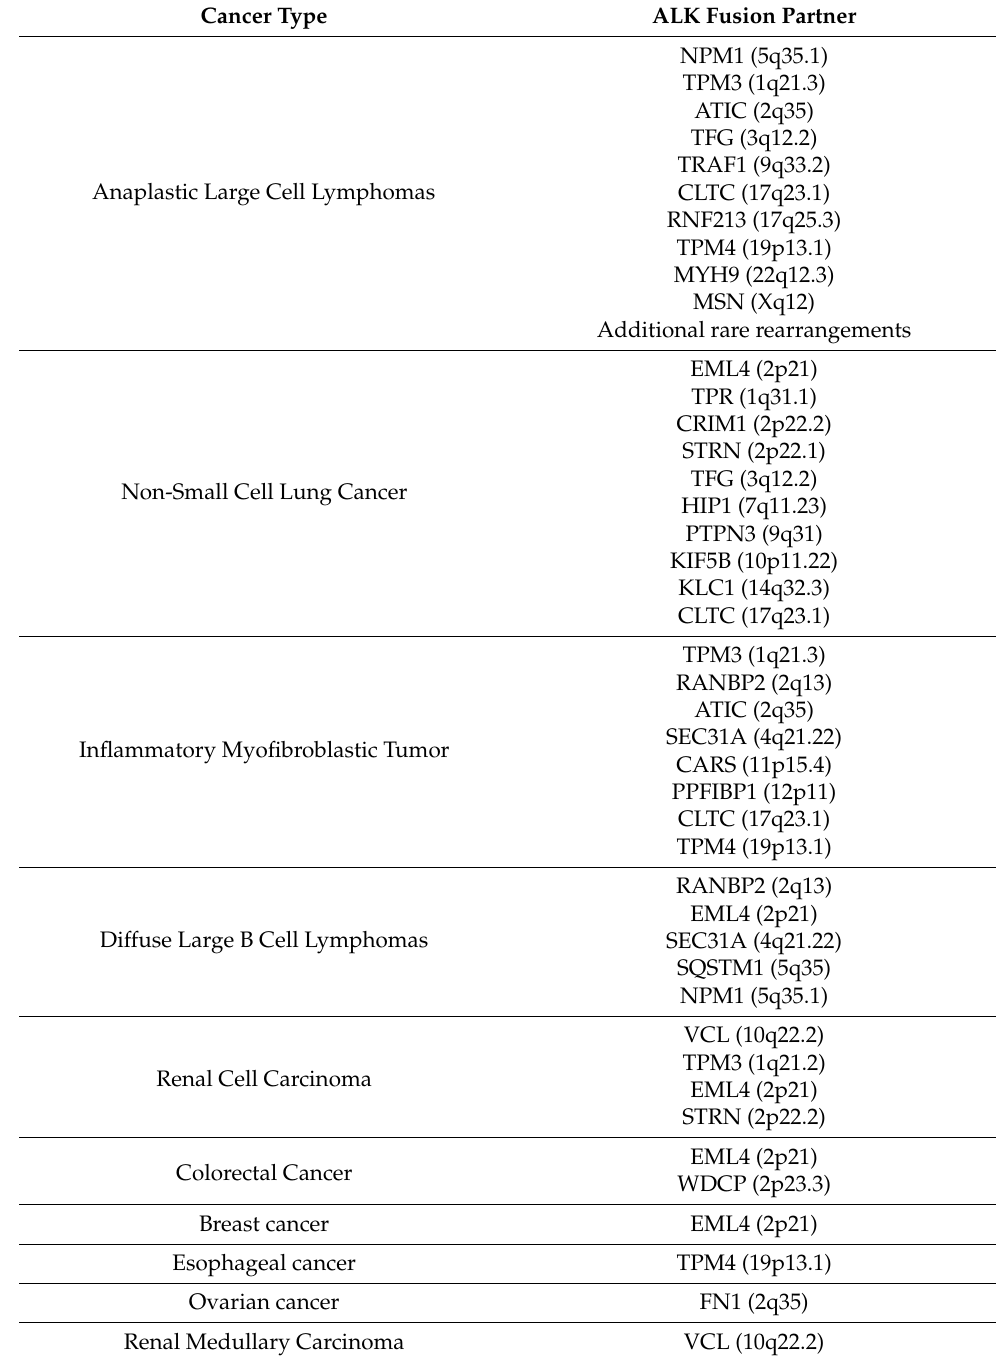
Table 1. ALK rearrangements in human